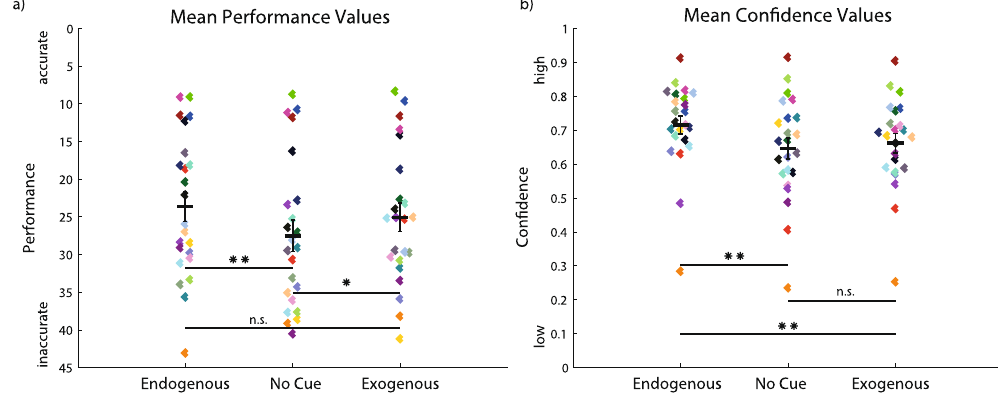
Figure 2. Performance and confidence compared across attention conditions. ( a ) Distribution of subject- averaged performance data. Every dot represents the mean performance of one participant in the respective condition. Every color corresponds to one participant showing how the individual participant contributed to the observed result. Both endogenous (left) and exogenous (right) attention conditions have greater means (grand average) than the no-cue condition (center). ( b ) Distribution of subject-averaged confidence data. Note the similarity of the exogenous and no-cue distributions. Means are indicated in black. Levels of significance were computed using post-hoc comparisons following a one-way repeated-measures ANOVA on mean values of participants. Asterisks denote significant results of the post-hoc comparison; ** p < 0.01, * p < 0.05, n.s.: not significant (p > 0.05). Error bars are standard error of the